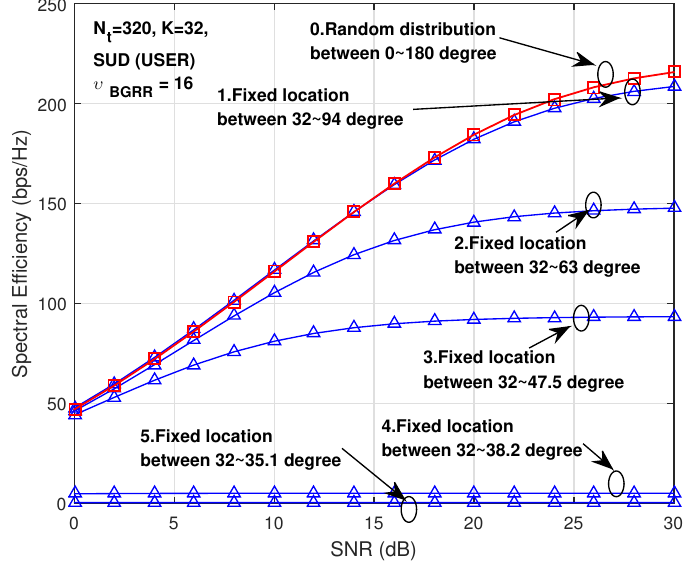
Figure 15. SE performance based on the space separations among UEs, when N t = 320, K = 32, χ DM − RS = 10, υ BGRR = 16, ZF